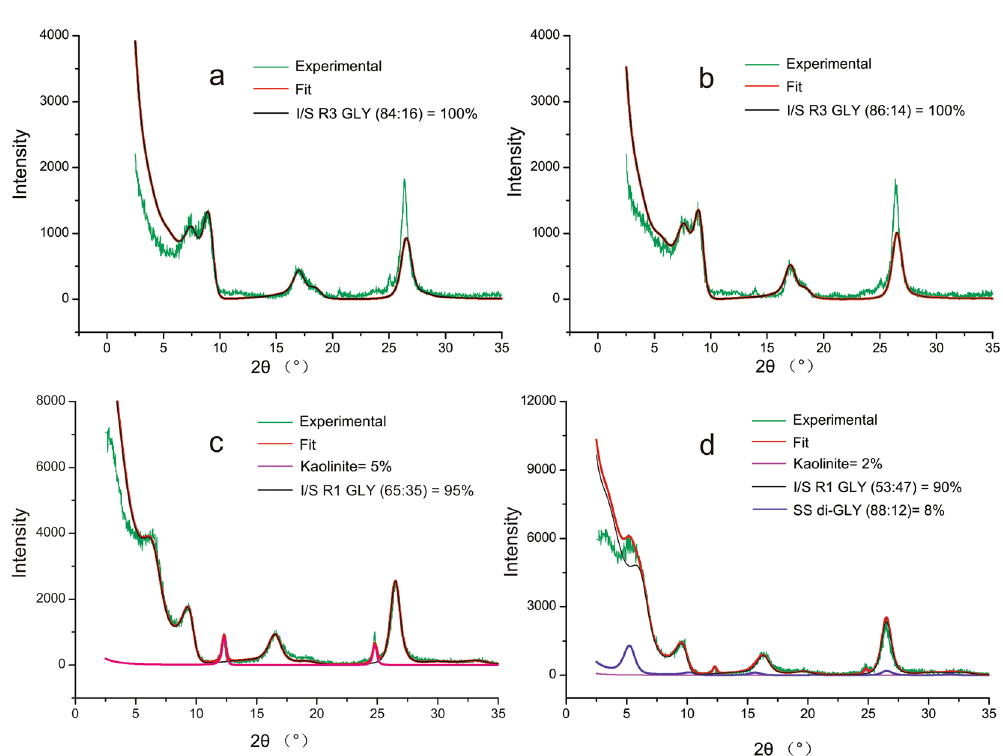
Figure 4. XRD profiles from Air-dried (AD) and EG-saturated (EG) of the I/S (illite-smectite) mixed layered clay minerals. The numerical values are the d values (nm) of the experimental